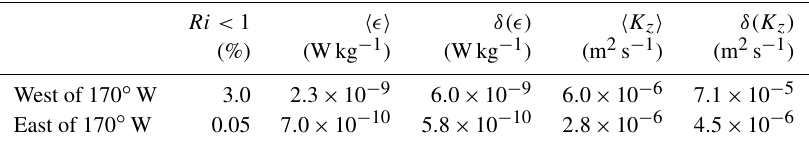
Figure 2. Surface geostrophic currents inferred from AVISO altimetric data (a) ; longitude–depth section of the 38kHz SADCP velocity modulus (b) ; bathymetry along the RV l’Atalante route (c) ; VMP stations are displayed with magenta circles in (a) and with vertical dashed red lines in (b) and magenta lines in (c) . Table 2. Statistics in the western and eastern parts: percentage of Ri < 1 and mean values and standard deviations of (cid:15) and K z within a 100–500m surface